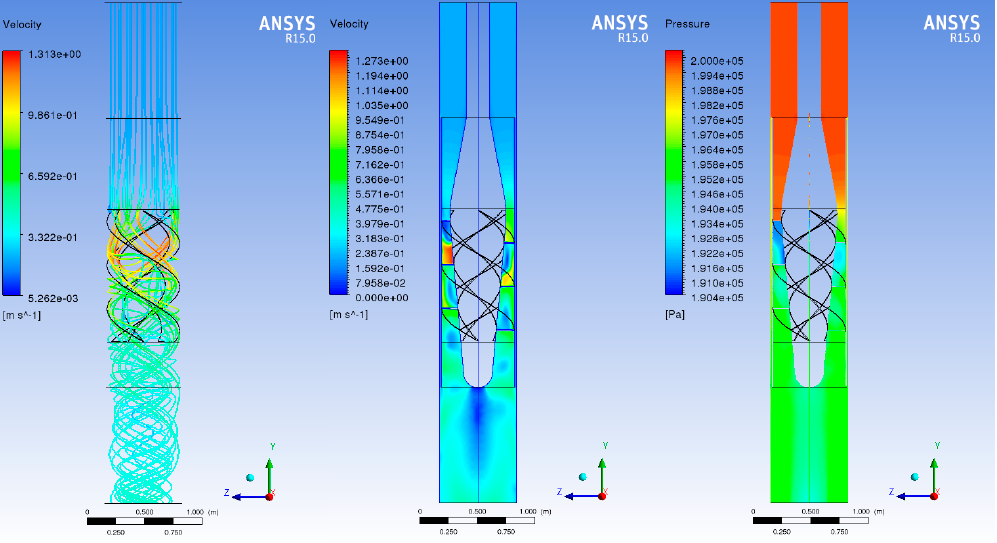
Figure 12. NC conditions: streamlines, velocity and pressure.